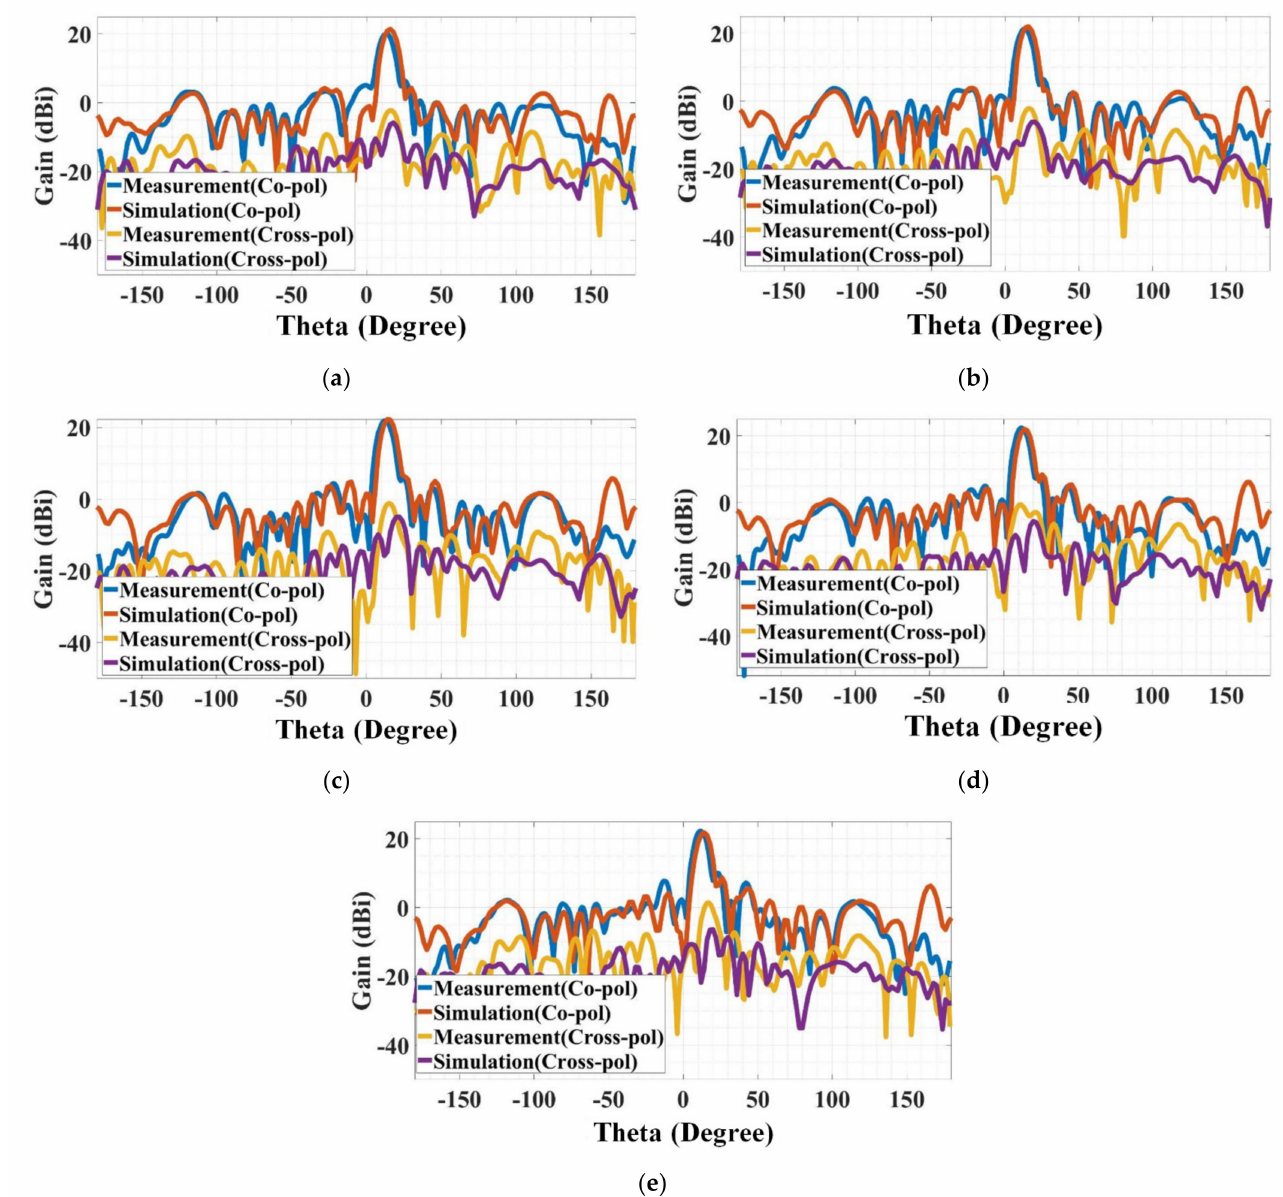
Figure 7. Measured gain patterns of the designed reflectarray antenna: ( a ) 5.6 GHz, ( b ) 5.7 GHz, ( c ) 5.8 GHz, ( d ) 5.9 GHz and ( e ) 6.0 GHz. Table 2. Simulation and Measurement Data. Co-pol Gain (dBi) Cross-pol Gain (dBi) Radiation Angle ( θ , ◦ ) Sim. Mea. Sim. Mea. Sim.